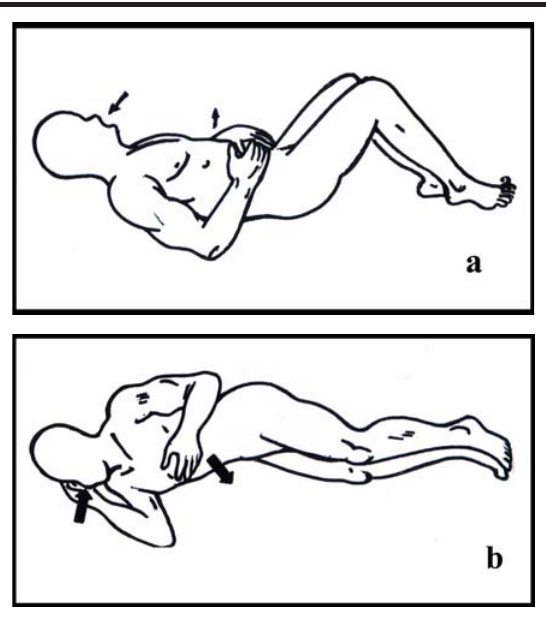
FIGURE 1 - Schematic drawing showing the positioning utilized in dorsal decubitus (a) and in lateral decubitus (b)